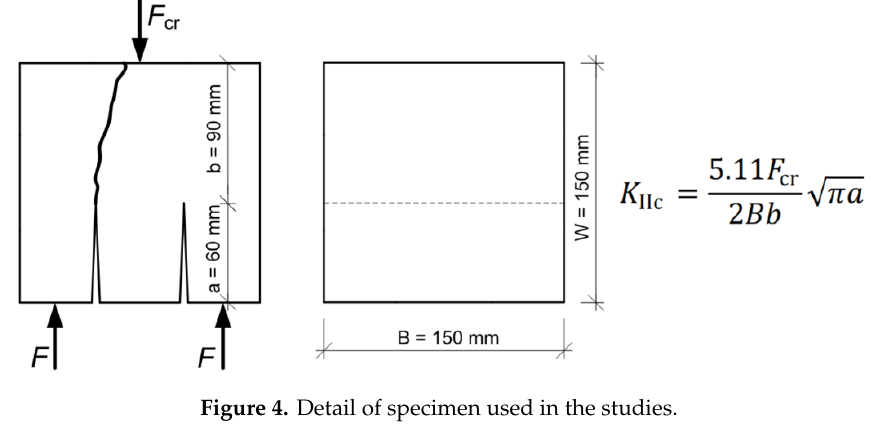
Figure 3. Specimen for the Mode II fracture tests during preparation (dimensions in mm). Figure 4. Detail of specimen used in the studies.